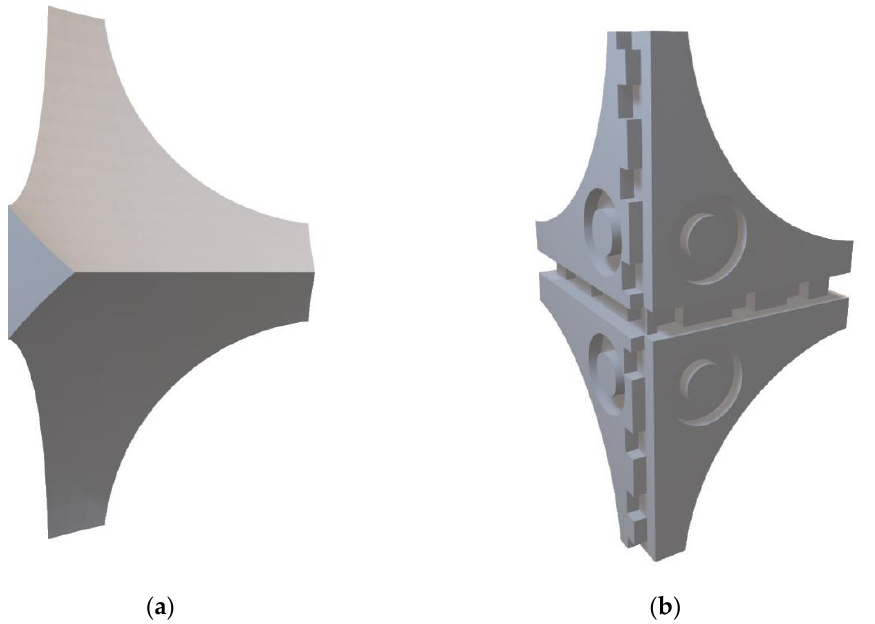
Figure 10. Artifact designed for the corners of the build space to even out the slice distribution. ( a ) Spherical surfaces towards the interior of the build space; ( b ) flat surfaces towards the exterior.